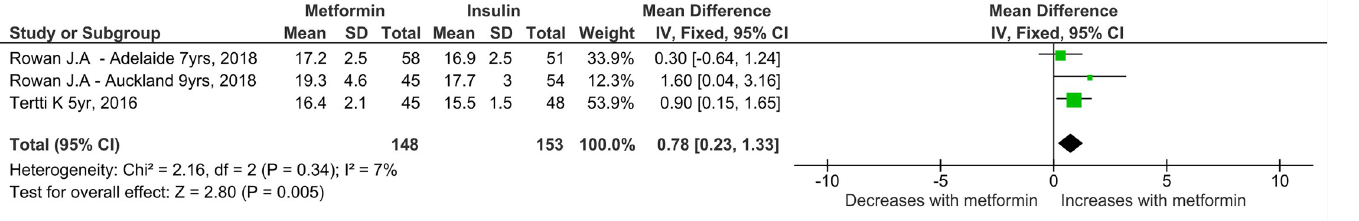
Fig 14. Childhood BMI. Expressed as mean differences (fixed effects model) and 95% CI. IV, mean difference.